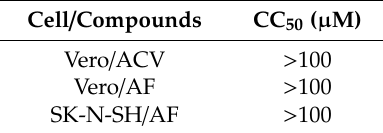
Table 1. The cytotoxicity of amentoflavone and ACV on Vero and SK-N-SH cells.